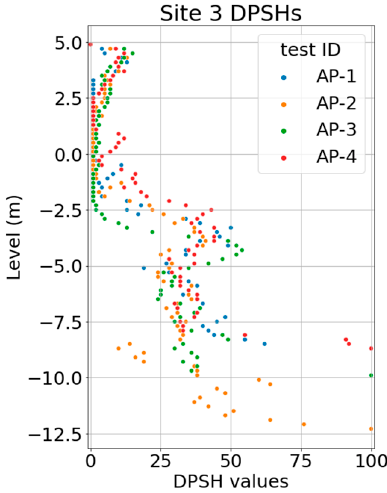
Figure 6. DPSH values for site